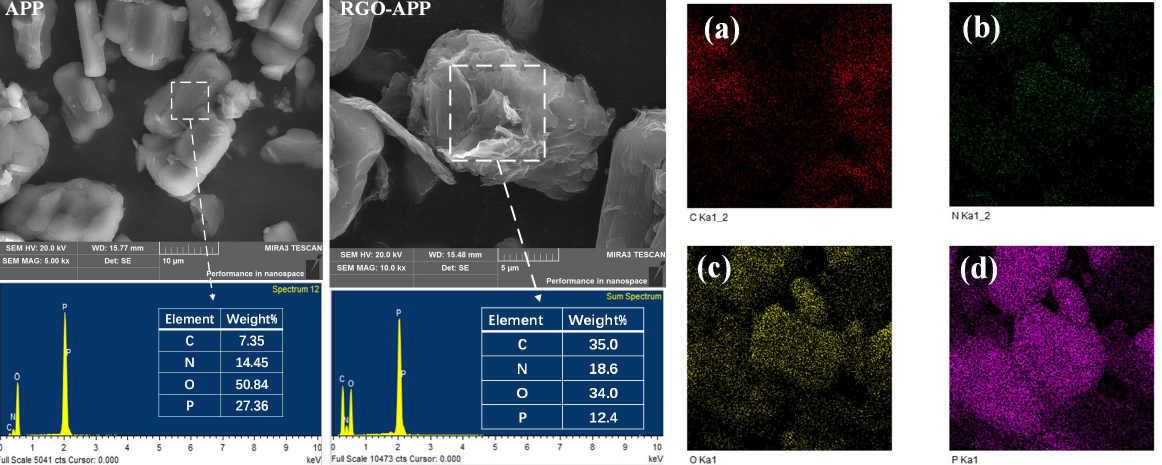
Figure 3. SEM images and EDS maps of APP and RGO-APP and element distribution of RGO-APP: (a) Carbon element, (b) Nitrogen element, (c) Oxygen element, (d) Phosphorus element.